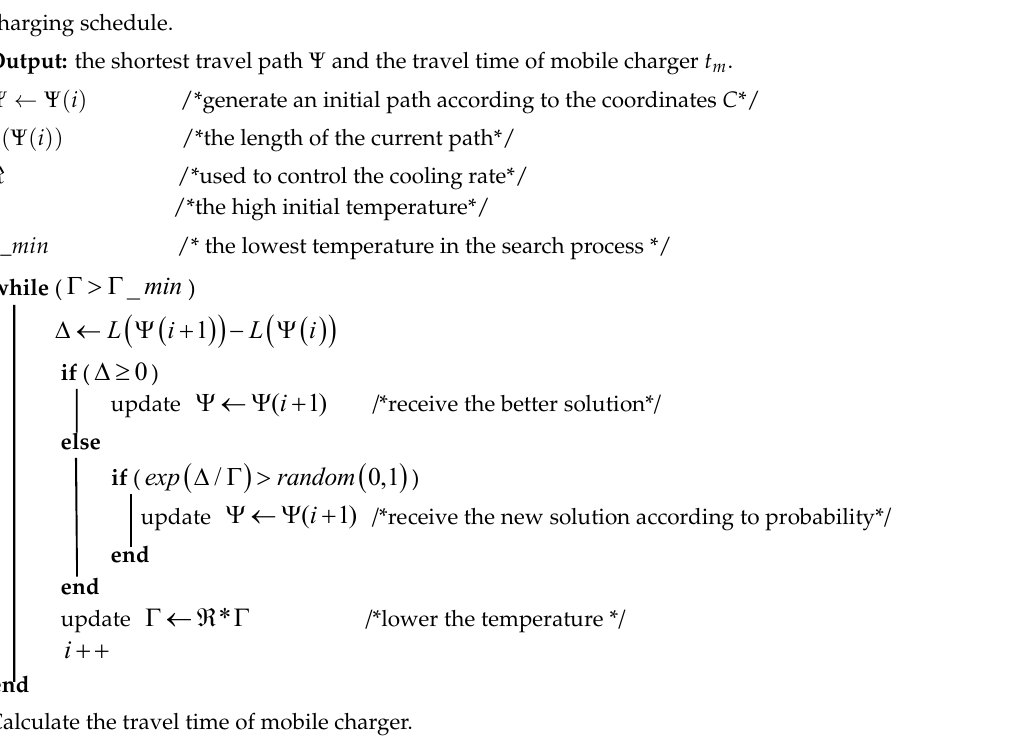
Algorithm 2: The Shortest Travel Path Based on the Simulated Annealing Algorithm